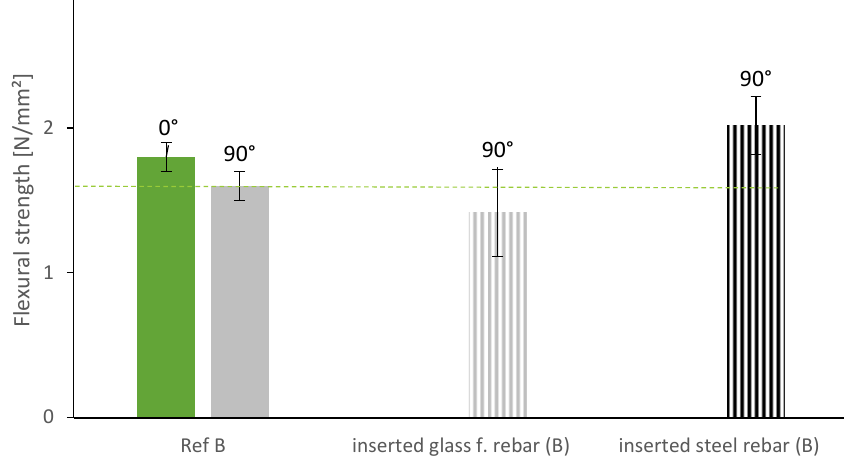
Figure 12. Flexural strength of specimen with vertically inserted rebars.